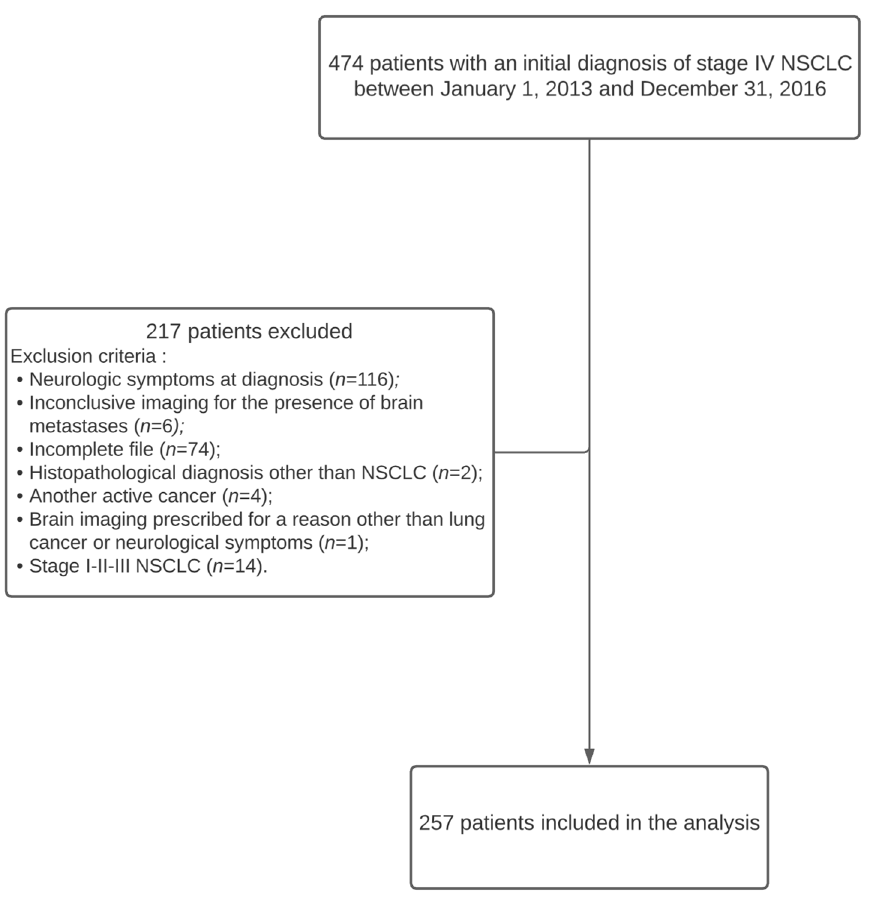
Figure 1. Consort diagram. NSCLC = non-small cell lung cancer.